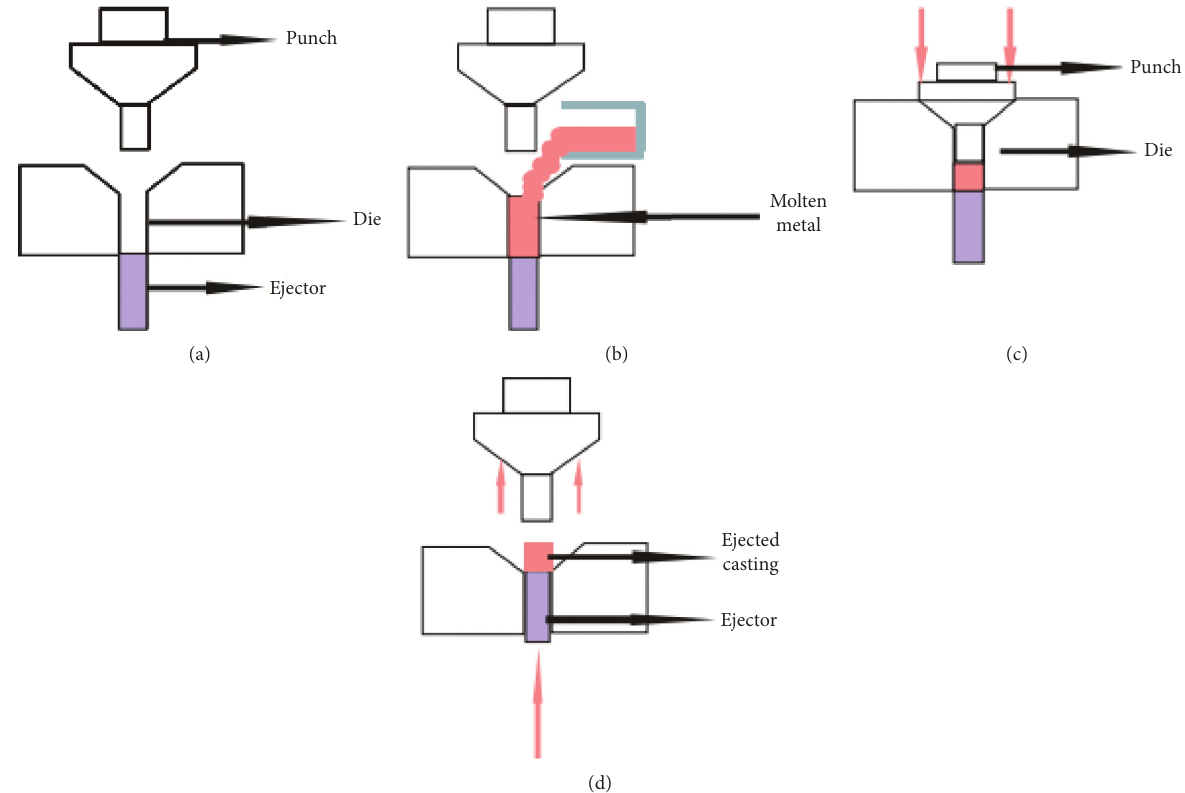
Figure 5: Schematic showing the sequence of steps during squeeze casting operation. (a) Preheated die and punch. (b) Molten metal poured into the die cavity. (c) Application of squeeze pressure. (d) Ejection of solidified casting